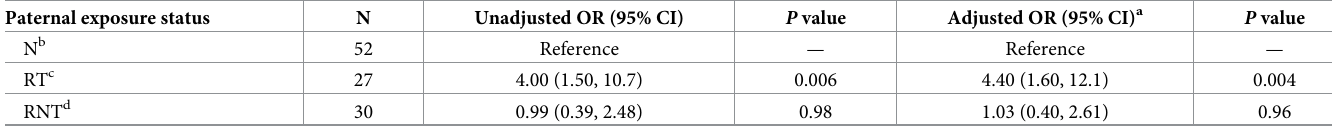
Table 3. Crude and adjusted odds ratios of having a female child of the RT and RNT